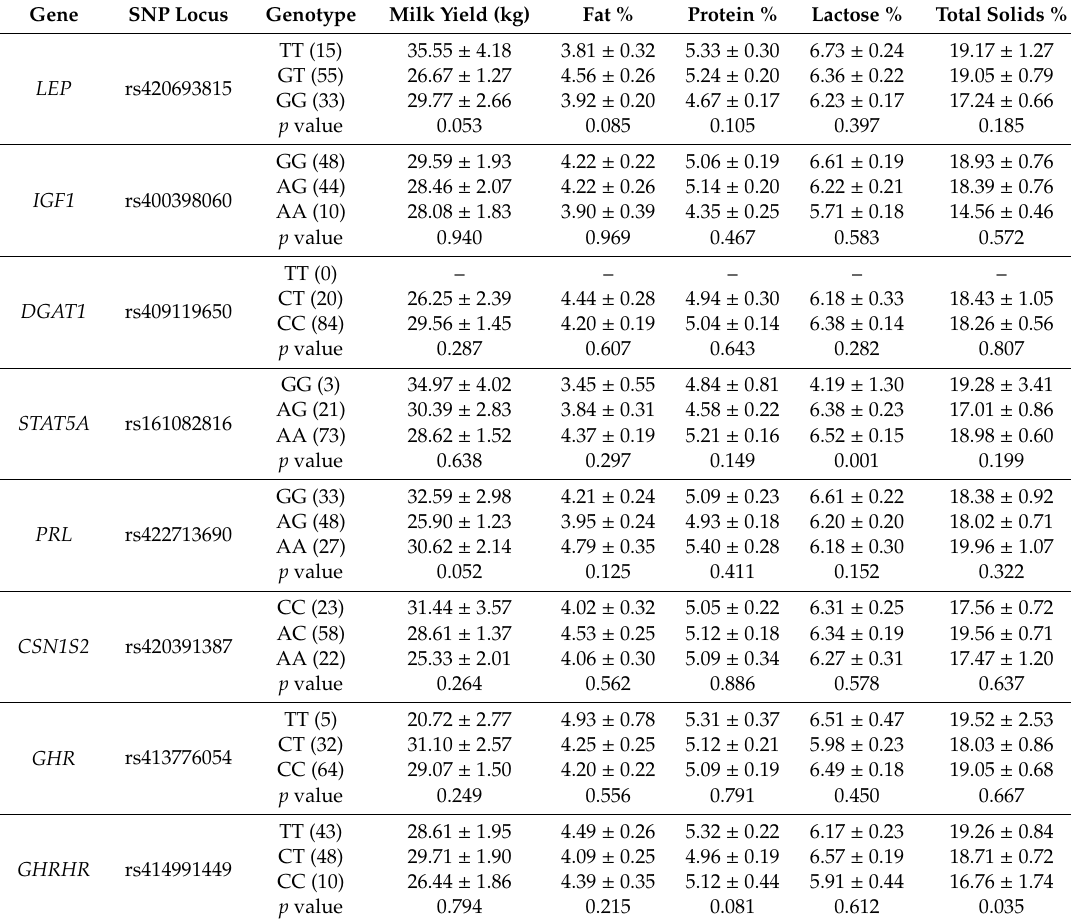
Table 6. Association of SNPs of studied genes with milk traits in Barki ewes (Mean ± SE). Gene SNP Locus